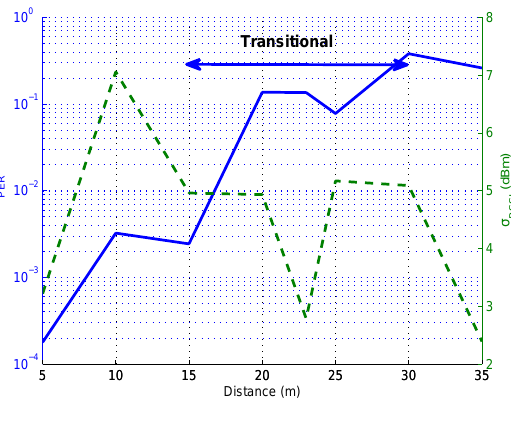
Figure 4. Standard deviation for PER and RSSI. Corridor Scenario.